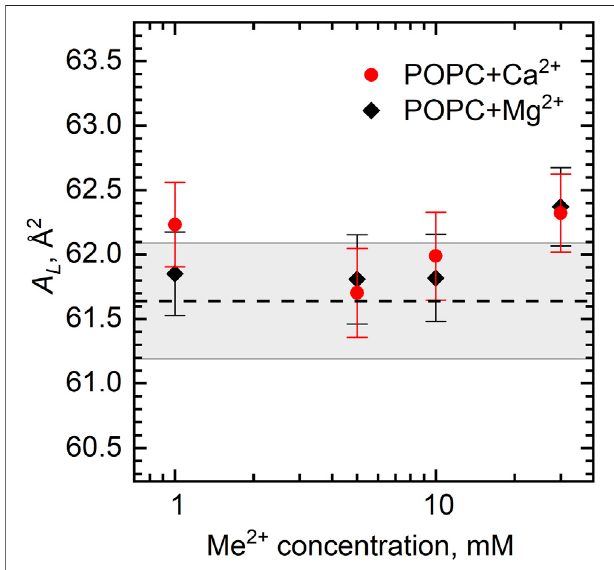
FIGURE 6 | Area per lipid A L of the POPC bilayer as a function of Ca and Mg 2+ concentrations. The dashed line represents A L of neat POPC with the wide gray band depicting its standard